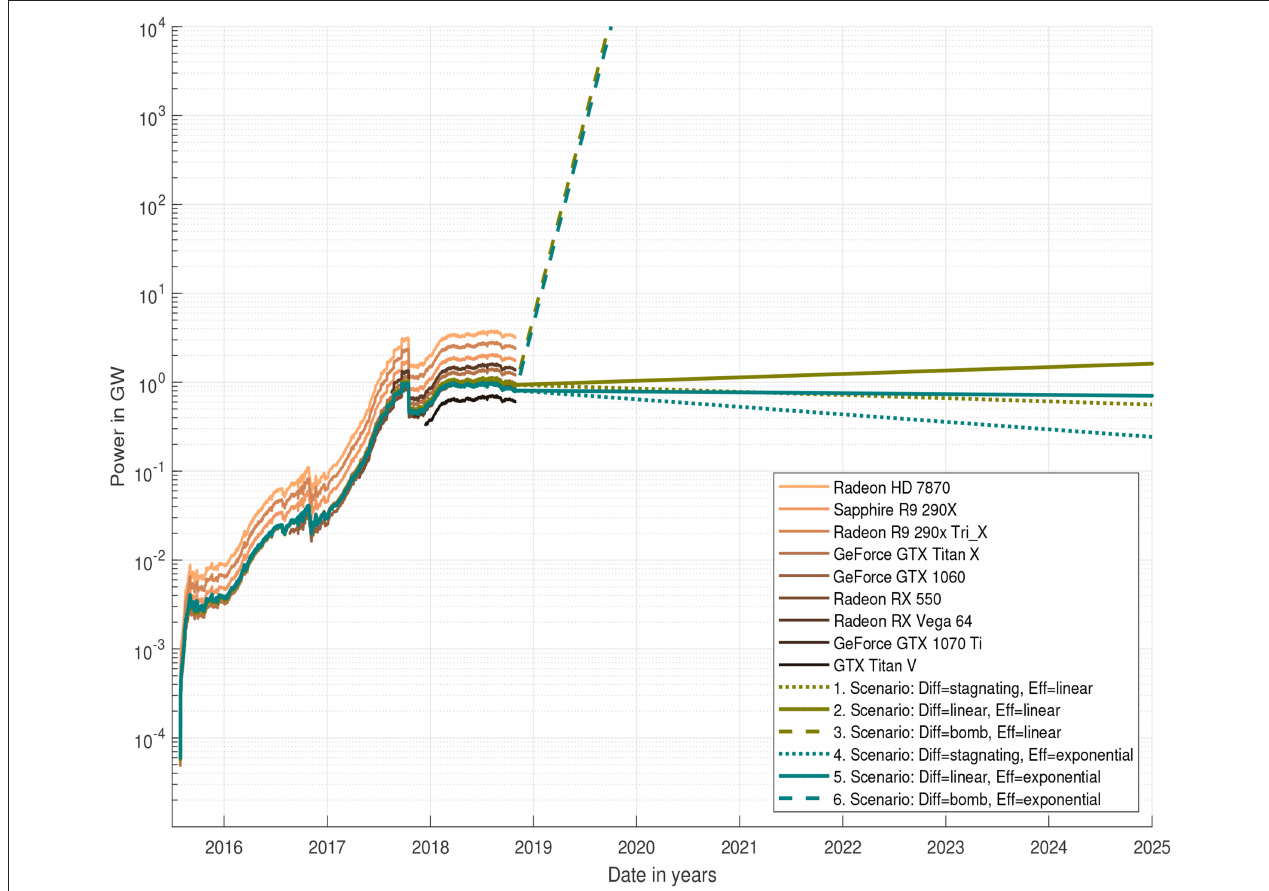
FIGURE 7 | Mining power demand of the Ethereum blockchain until October 2018 if only one hardware was used throughout the network and scenarios 1–6 until 2025 for the future development of the power demand. Ethereum hardware data from Zade and Myklebost